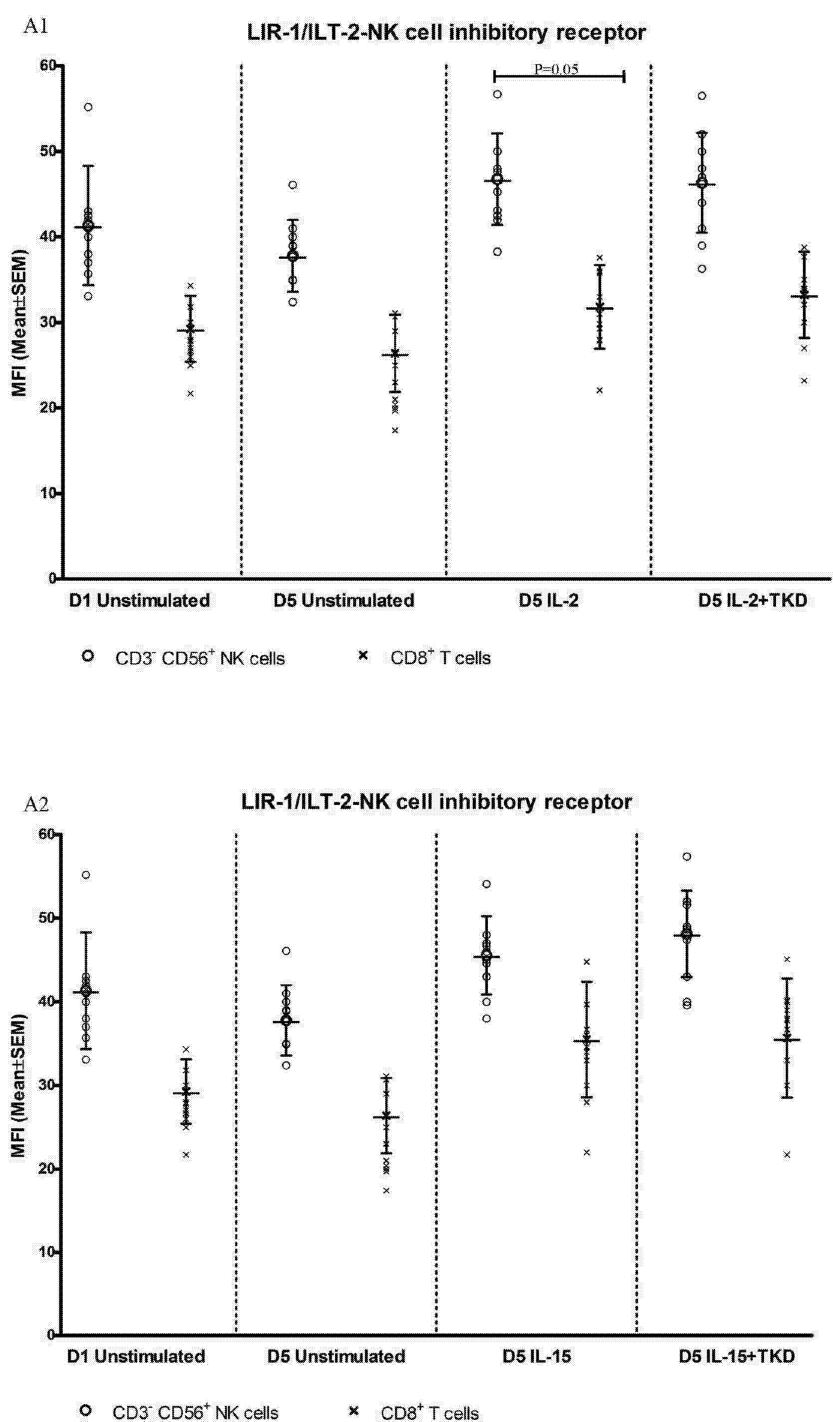
Fig 19. The effect of IL-2, IL-15, IL-2/TKD and IL-15/TKD on the expression of LIR1/ILT-2 in peripheral blood mononuclear cells of healthy individuals — the amount of receptor expressed by CD3 - CD56 + NK cells and CD8 + T cells (the median fluorescence intensity). The amount of LIR1/ILT-2 expressed by CD3 - CD56 + NK cells and CD8 + T cells was examined within the fraction of unstimulated and stimulated mononuclear cells derived from 10 healthy individuals. Data are presented as means ± standard error. In total, the study cohort consisted of 52 Caucasian healthy